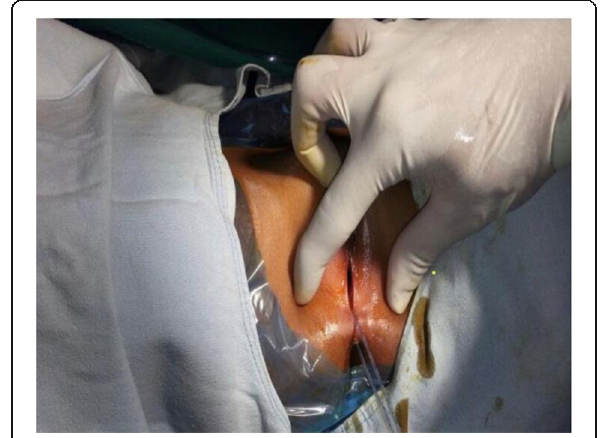
Fig. 2 Cannulation of the fistula from the anal canal to the vestibule (Tsuchida ’ s procedure